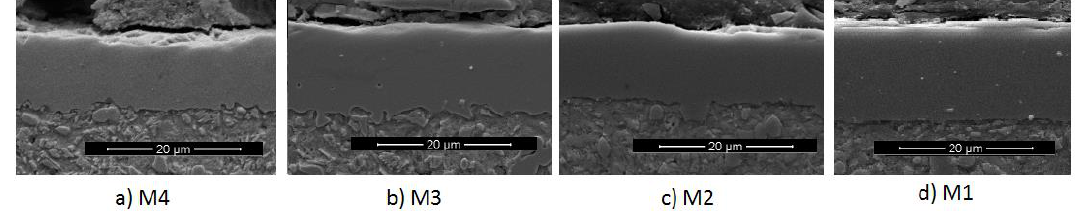
Figure 2. SEM micrographs of the ( a ) M4; ( b ) M3; ( c ) M2; and ( d ) M1 samples.